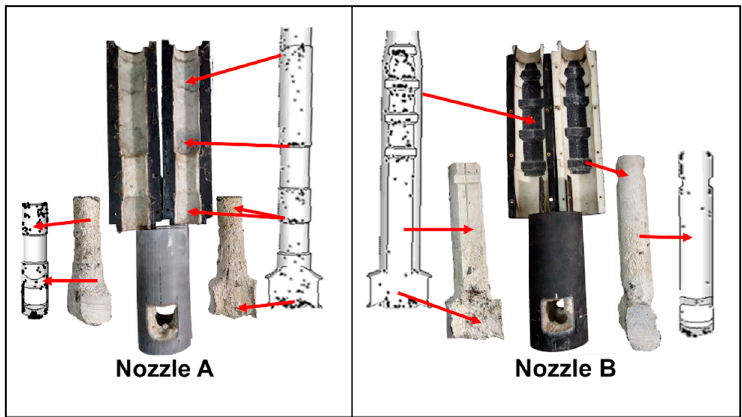
Figure 14. Comparison between the deposited zones for the real nozzle and the simulated nozzle. Reproduced with permission from [45], Wiley-VCH GmbH, 2020.